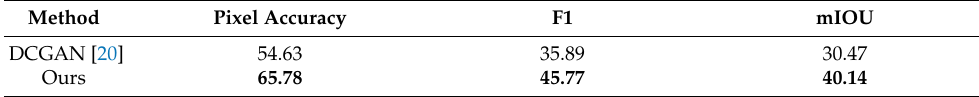
Figure 10. Unsupervised learning-based Cityscapes qualitative results. ( a ) Original image, ( b ) input map, ( c ) DCGAN, ( d ) ours, ( e ) ground truth. Table 5. Results on